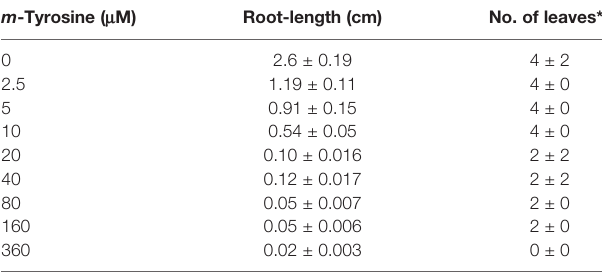
TABLE 1 | Effects of m -tyrosine on root length and leaf number of 5-day-old Arabidopsis thaliana (col-0) seedlings. m -Tyrosine ( m